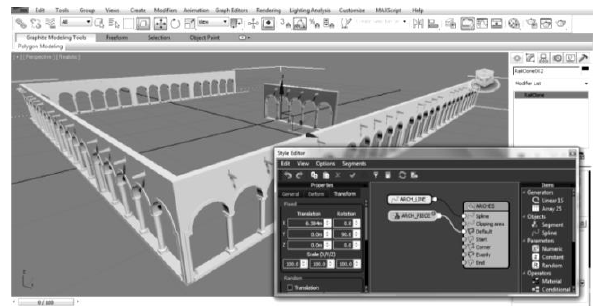
Figure 11. Detail and application of arcade style, based on Linear Array. This one had only two parameters: length and active component.